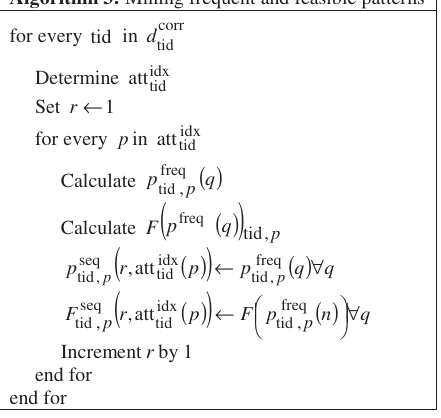
Figure 4: Pseudo Code for Mining the Frequent as well as the Feasible